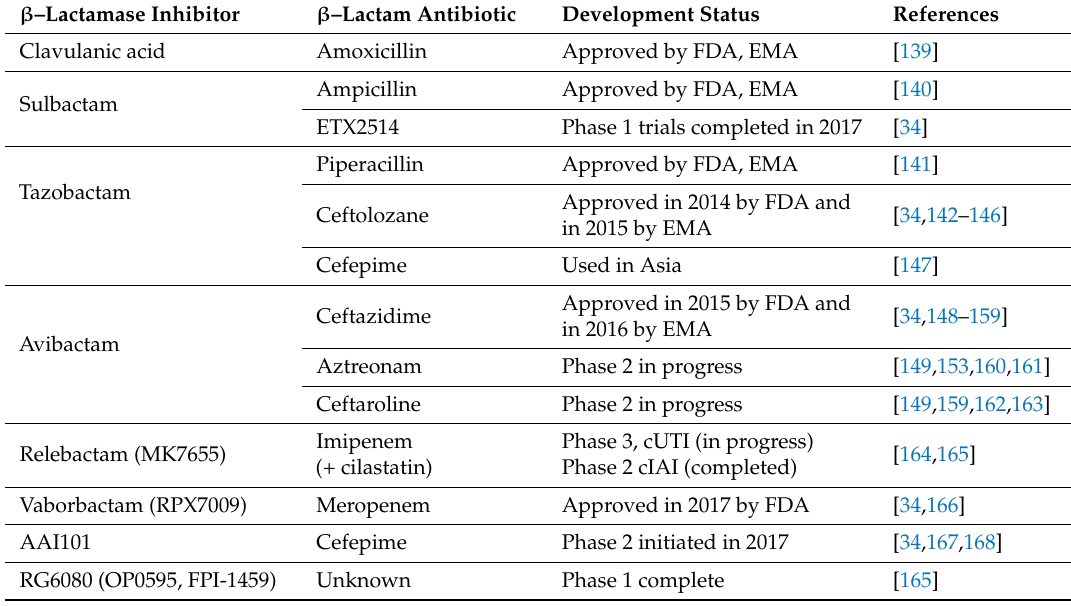
Table 3. Combinations of β -lactamase inhibitors and β -lactam antibiotics of clinical use (Adapted from Docquier and Mangani et al. [34] and Bush